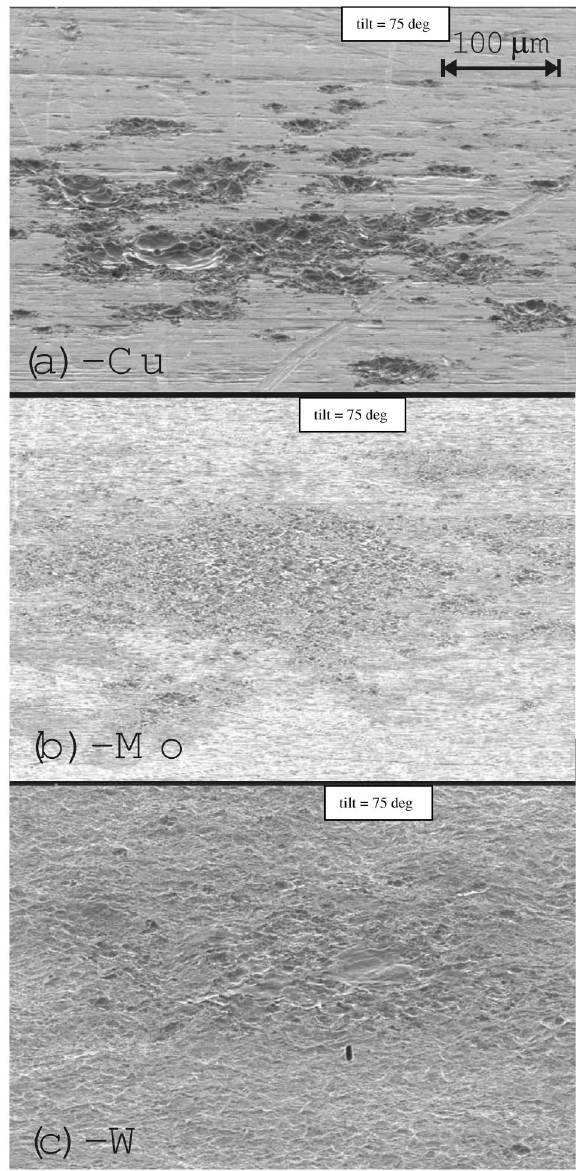
FIG. 7. SEM image magnified view ( 2500 (cid:3) ) of the regions in Fig. 5. The arrow indicates 10 (cid:14) m